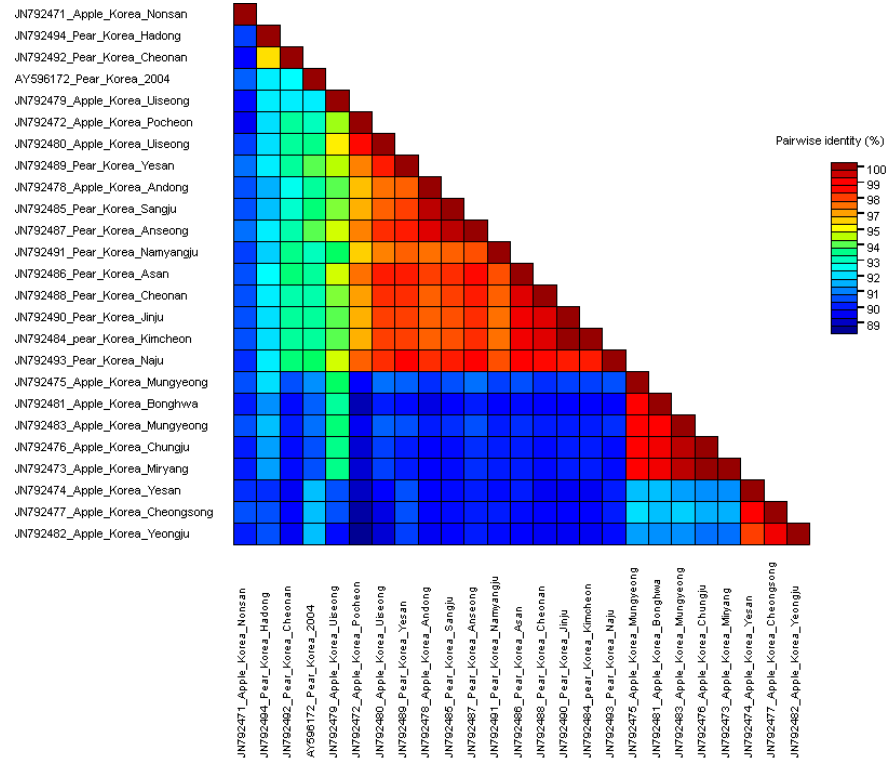
Figure 2. Apple stem grooving virus (ASGV) coat protein gene nucleotide sequence identities. MUSCLE alignment was used implemented in Sequence demarcation tool (SDTV1.2). Microorganisms 2021 , 9 , x FOR PEER REVIEW The isolates from the pear group exhibited significant differences in nucleotide sequence identity up to 10% against the apple isolates (Figure 6). Four apple isolates cluster into clade 1, GenBank JN792472 (Pochen), JN792479 (Uiseong), and JN792480 (Uiseong) (Figure 4). Although the pear isolates were collected from far flung distant areas, the pear isolates showed close relationship with each other and were distinguished from the apple isolates (Figures 1 and 4). Isolates from apple and pear identified from the same or nearby regions did not show much relevance. For example, the accession with GenBank JN792492 from Yeongju in pear and JN792478 from Andong in apple were collected from nearby regions were clustered in distinct clades 2 and intermediate 1 clade, respectively (Figures 4 and 5). Similarly, the two accessions from Yesan (GenBank JN792474 (apple) and JN792489 (pear)) shared only 90.0% nucleotide and 91.5% amino acid identities with each other (Figures S1 and S2). The distribution of the Yesan isolates into distinct clades, i.e., clade 4 and intermediate 1 clade (Figures 4 and 5) indicates the isolation host specificity (also evident from Figure s 2 and 3).